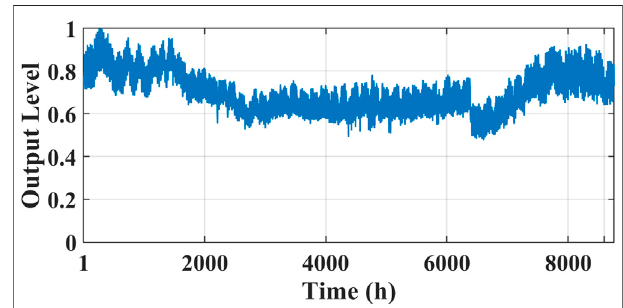
FIGURE 5 | Annual load curve.